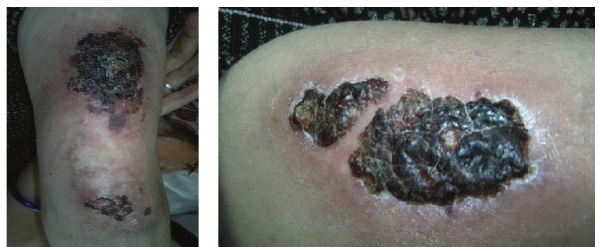
Figure 1: Pictures of the ulcers on the arms of the patient. Crustations have developed on the ulcers.